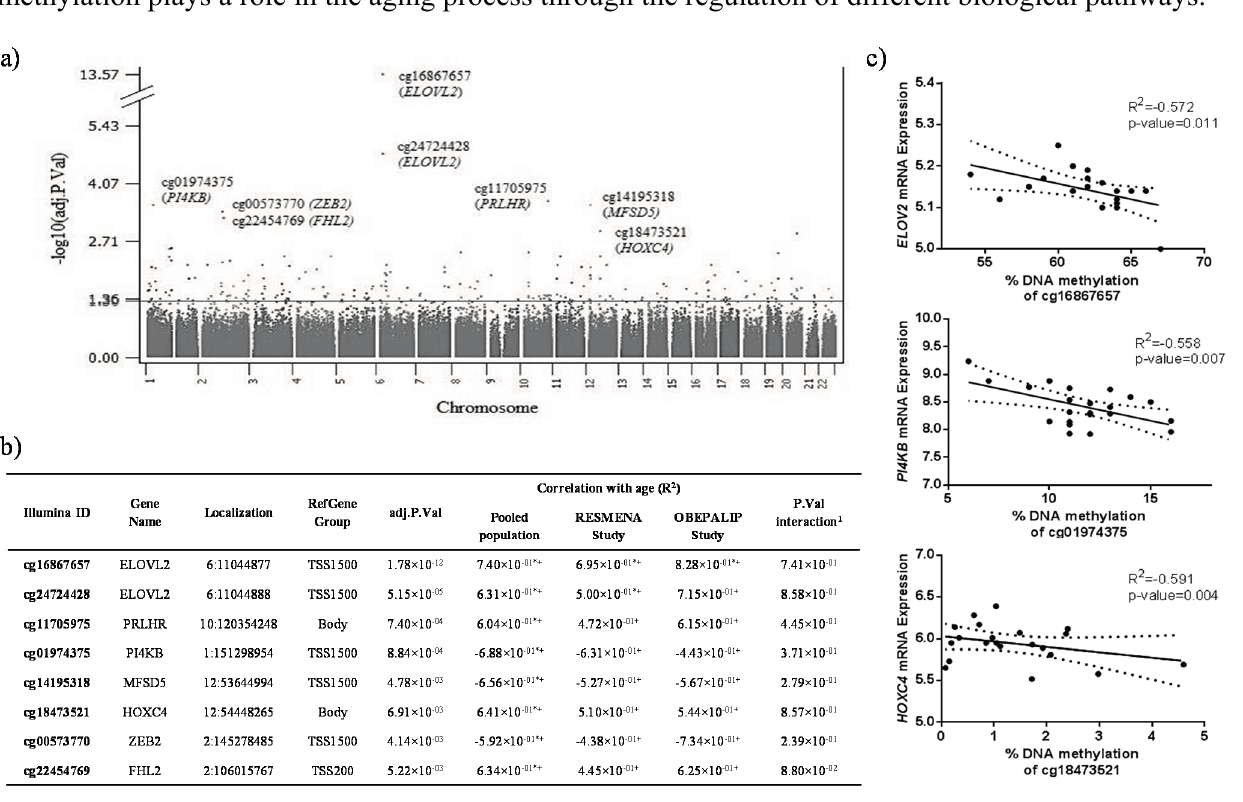
Figure 1. Associations between age and DNA methylation in different CpGs. ( a ) Manhattan plot of genome-wide p -values from the pooled population; ( b ) Adjusted p -values and Spearman correlation coefficients of the selected CpG sites with respect to age. CpGs are ranked by adjusted p -value, from smallest to largest. The number of subjects included in the pooled population, RESMENA study and OBEPALIP, were 73, 48 and 25, respectively. 1 p -value of age-cohort interaction analyzed with a linear regression. * denotes statistical significance at adjusted p -value < 0.05; + denotes statistical significance at raw p -value < 0.01; ( c ) Graphical representation of the correlation between DNA methylation levels of the selected CpG sites and mRNA expression of the respective genes in RESMENA study ( n = 24). Data are presented as linear regression (solid straight line) graph and 95% confidence interval (dotted lines). Localization: Chromosome on which the target locus is located and genomic position of C in the CpG dinucleotide; RefGene Group: Gene region feature category; adj.P.Val: adjusted p -value for multiple